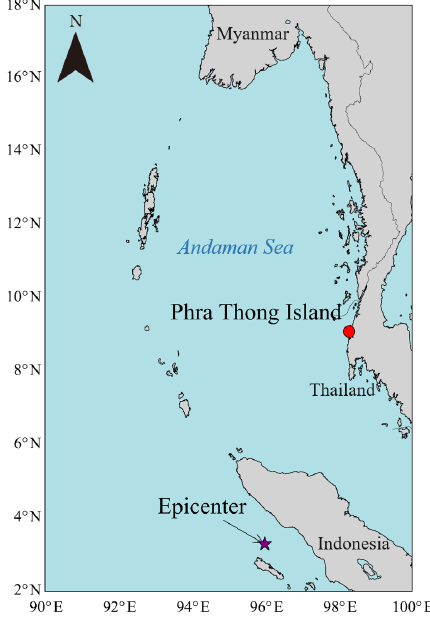
Figure 1. Location of Phra Thong Island.